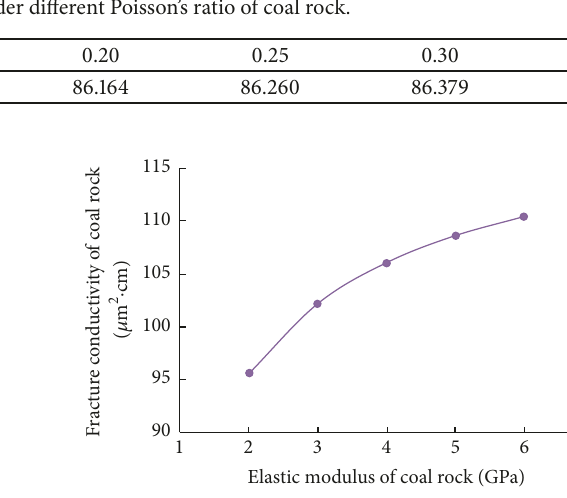
Figure 8: Relationship curve of fracture conductivity and Poisson’s ratio of coal rock.